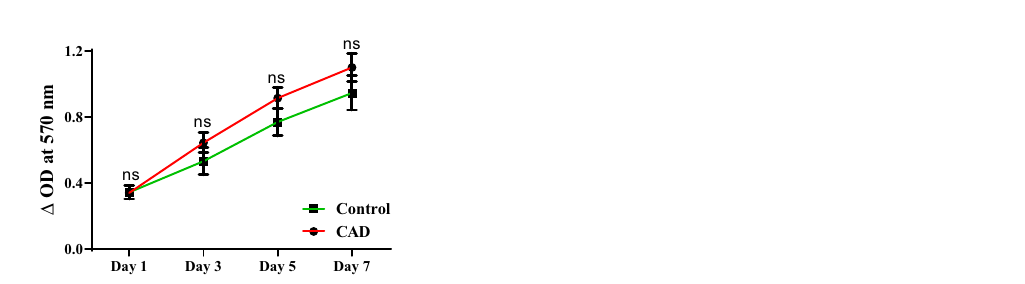
between the groups. After treatment with SIN-1 for 24 h the ECFC’s when observed under bright field microscope showed a changed morphology with elongated shape whereas untreated cells showed the typical cobble stone morphology (Supplementary figure 8). The effect of SIN-1 on proliferative potential of ECFCs, assessed in terms of expression of cell nuclear antigen Ki67, was found to be significantly p = 0.02) lower in SIN-1 treated ECFCs compare to untreated cells (Fig. 11). After 24 h of SIN-1 treatment significantly lesser number of ECFCs migrated to the lower transwell chamber as compared to the untreated ECFCs (67.8 ± 3.8 vs 160 ± 20; p = 0.012) (Fig. 12).